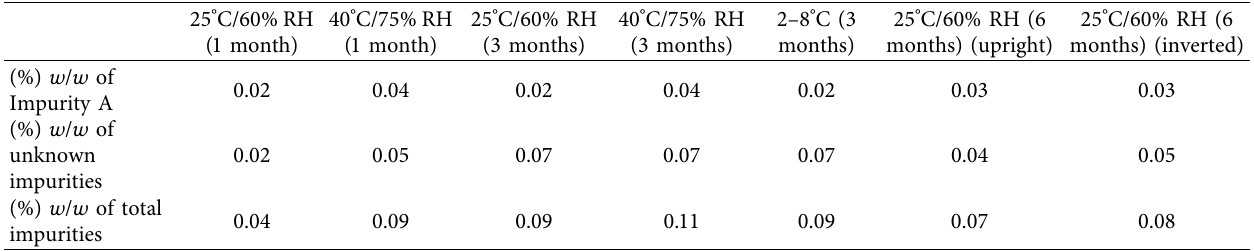
Table 10: Accelerated stability study of NMS injection studied from 1–6 months at various temperature and humidity conditions.